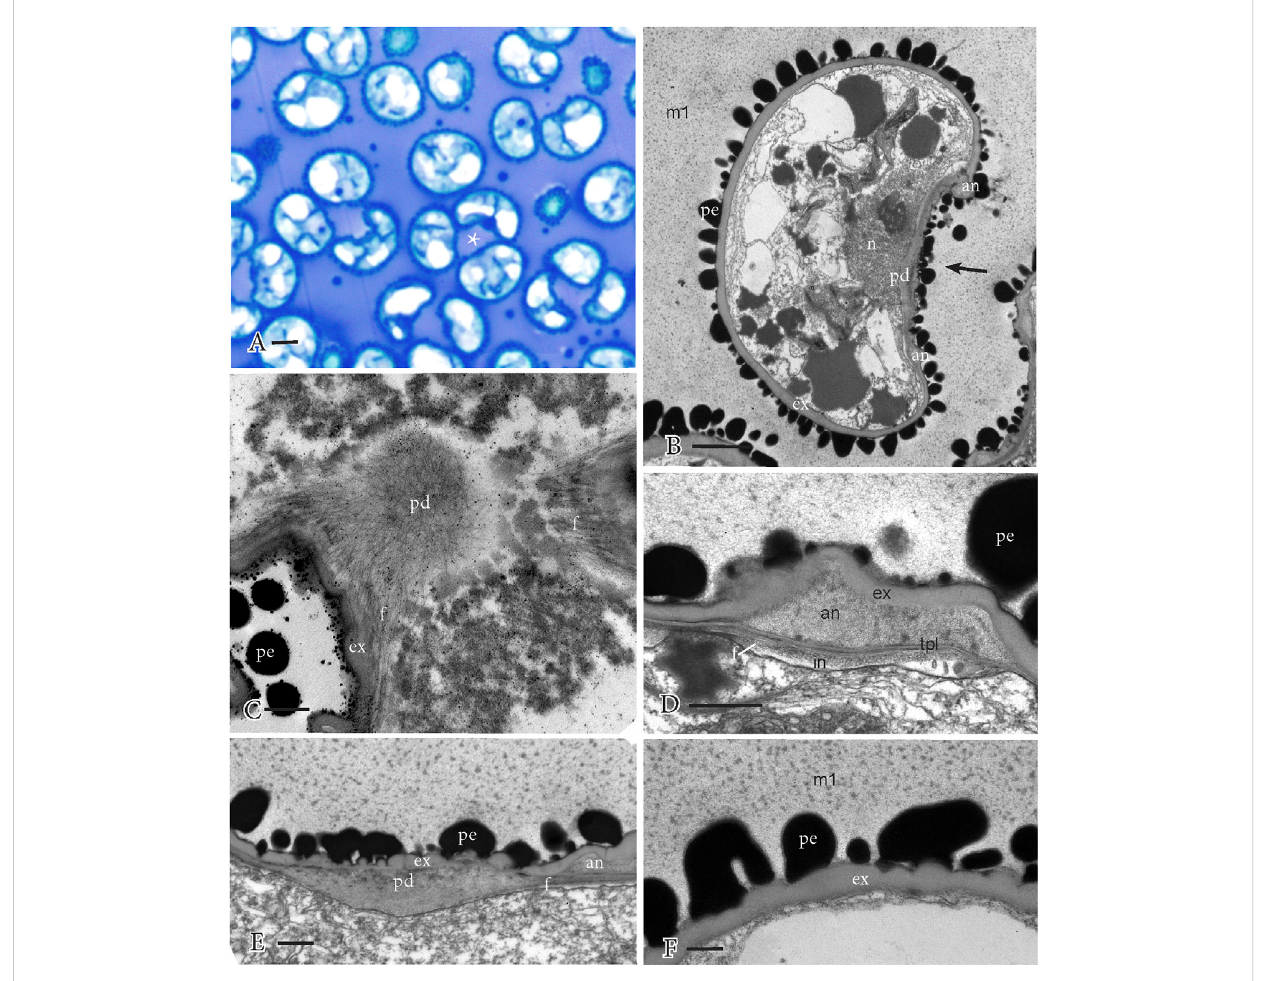
FIGURE 5 Perine development and aperture substructure. Perine ornamentation formed through the adherence of sporopollenin globules from the previous stage. The locular matrix (m1) is no longer fi brillar and contains abundant small dense inclusions. (A) LM of spores dispersed in the locule in tetrahedral arrangement and often with a concave proximal spore surface (*). (B) TEM of spore with a sparse cytoplasm, surrounded by the exine (ex) and truncated perine (pe) spikes along the distal wall. The aperture extends along the proximal face (arrow), which is concave and covered by an irregular perine. Theaperturepad(pd)andtheannulus(an)arereducedinstature.Theglobulesareabsentfromthelocularmatrix,andonlysmalldenseinclusionsremain. (C) TEMsurfacesectionoftheapertureshowinga fi brillar network ofthecentralpad(pd)andradiating fi bers(f).(ex),exine;(pe),perine. (D) TEMdetailsof the annulus (an) regions of the aperture, which is inserted between the TPL and undulating exine (ex). Fibers (f) extend from the pad under the TPL and intine(in)isexpandinginwardly.Anirregularperine(pe)coversthespore. (E) TEMdetailsofthecentralpad(pd)regionoftheapertureontheproximalside of a concave spore shows the fi bers (f) that extend beneath the annulus (an) and the irregular exine (ex) and perine (pe). Small dense inclusions are dispersed in the matrix around the spore. (F) TEM details of the distal spore side with exine (ex), truncated perine (pe) ornamentation, and no intine development. Small dense inclusions are dispersed in the matrix (m1) around the spore. Scale bars: (A) = 5.0 μ m; (B) = 2.0 μ m; and (C − F) = 0.5 μ